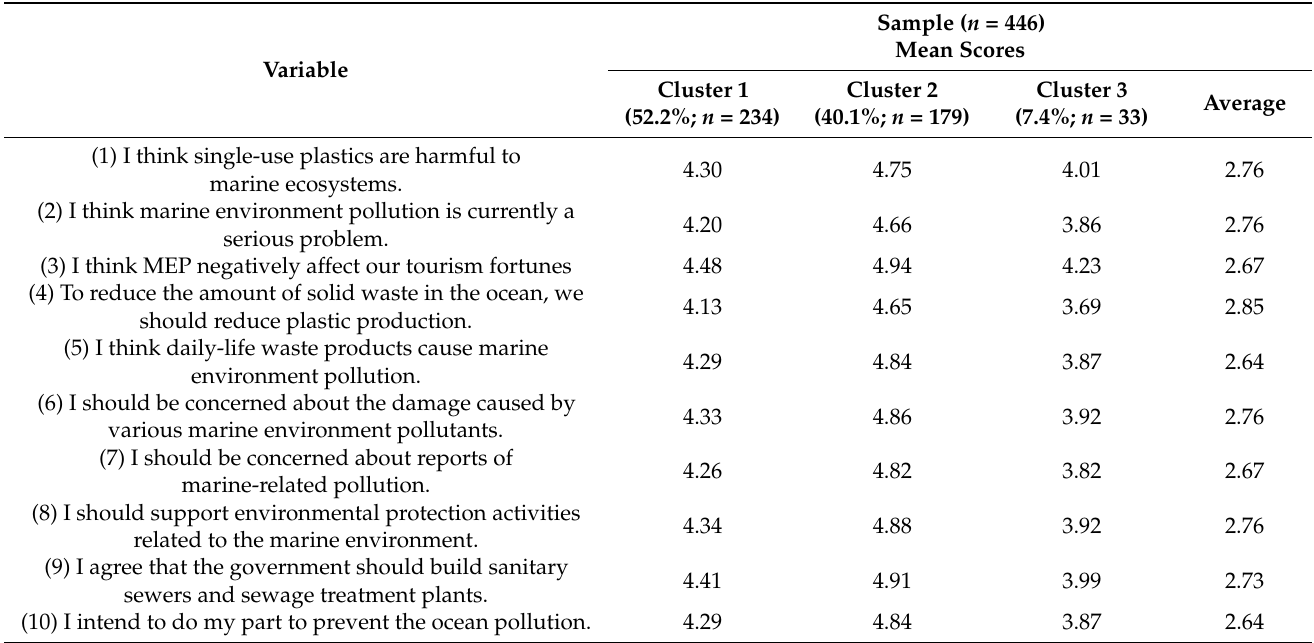
Table 3. Attitude-based clusters related to marine environment pollution (MEP).